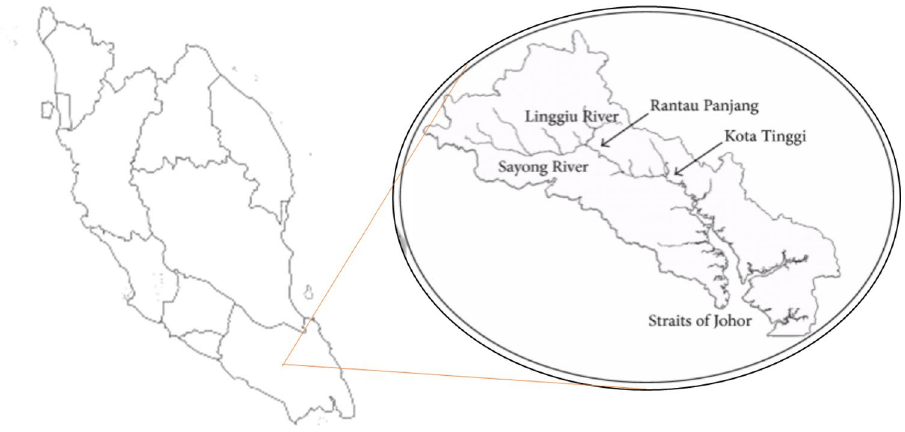
Figure 1. Illustration of the Johor River basin 35